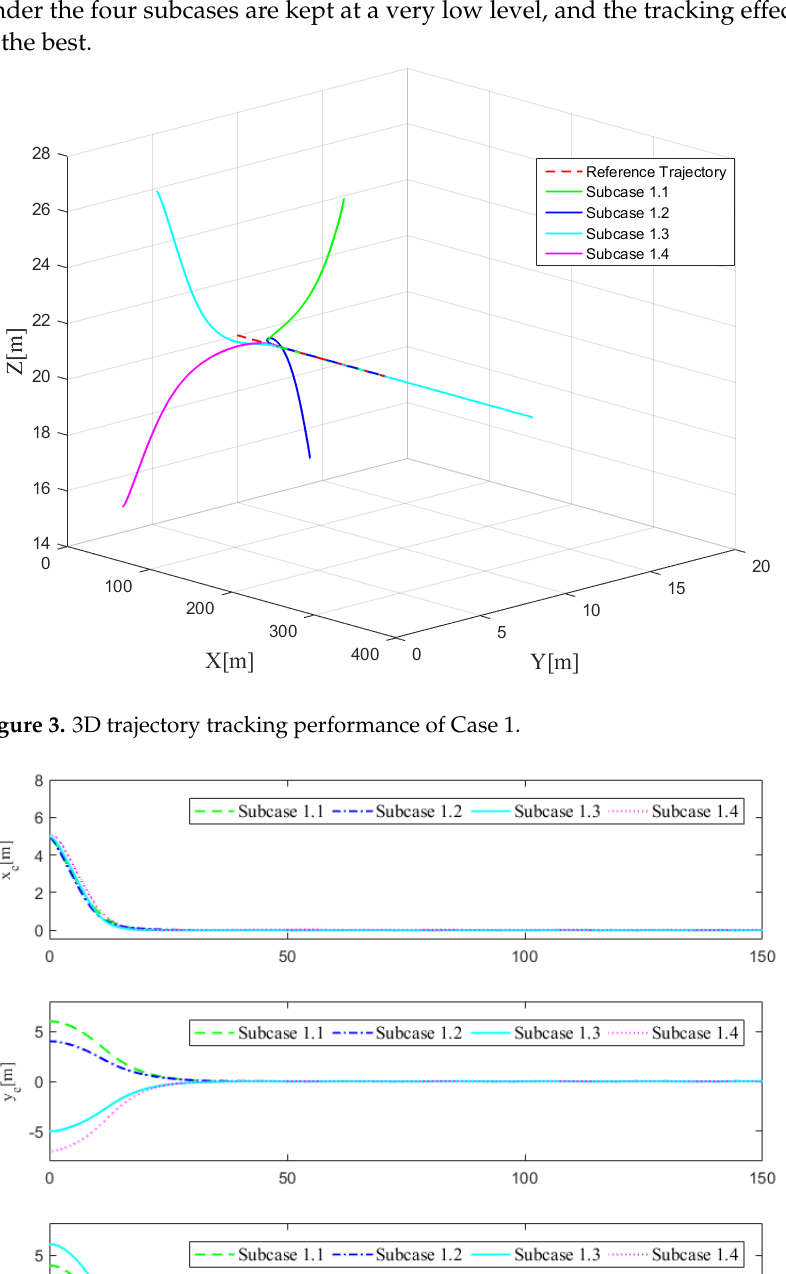
Table 6. Data analysis of steady-state for Case 1 (from 40s to 150s). Subcase 1.1